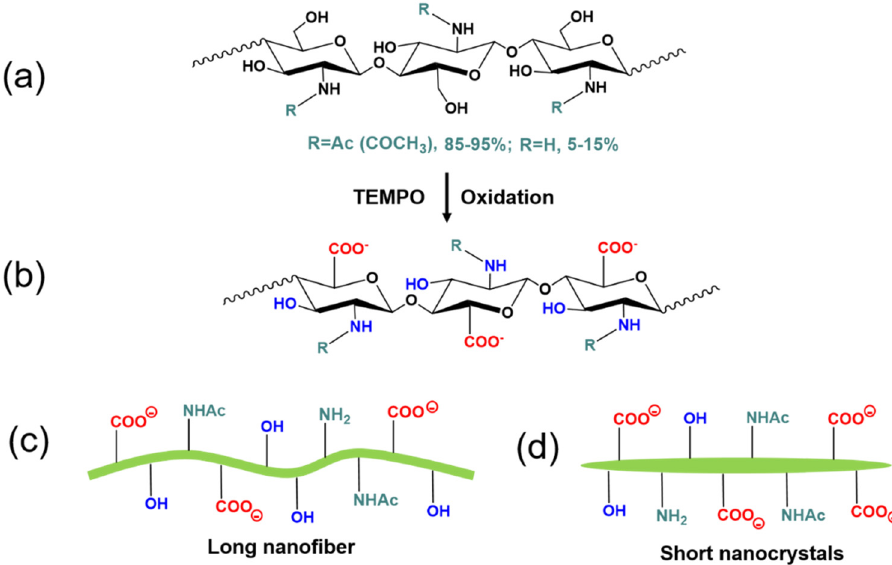
Figure 5: ( a ) Chemical structure of unmodi fi ed chitin; ( b ) chemical structure of carboxylated chitin; ( c ) scheme of carboxylated chitin